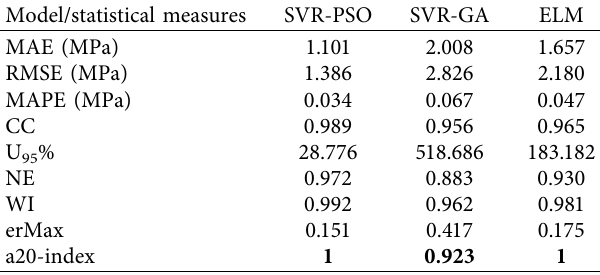
Table 3: Assessing the performance of each suggested model: testing